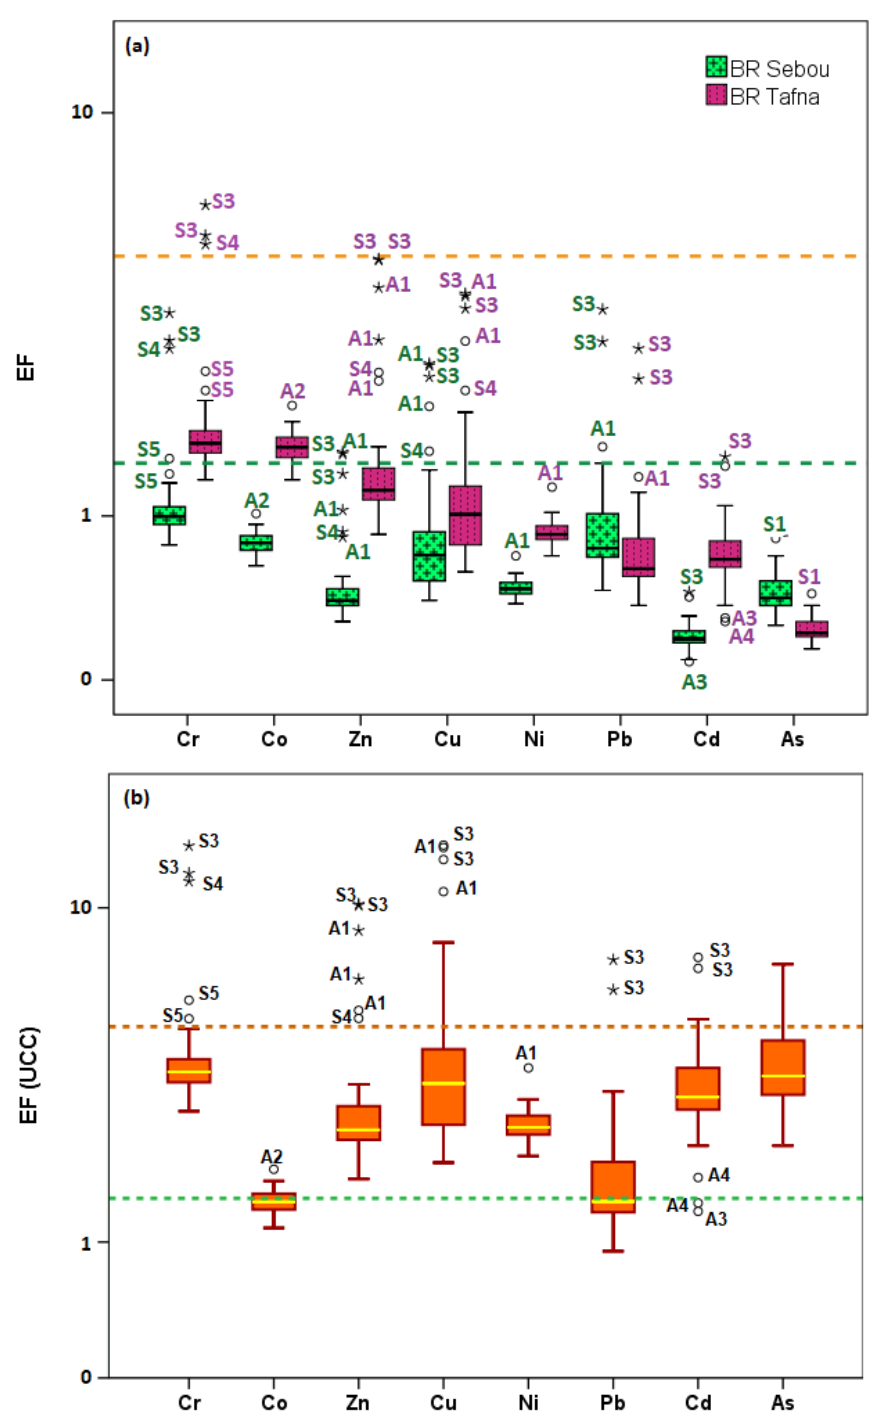
Figure 4. Comparison between the enrichment factor (EF) of trace metals in the river sediments from the Sebou basin normalized to the composition of: ( a ) the bedrocks (BR) of the Sebou (green) and the Tafna (pink) basins and ( b ) the UCC (Upper Continental Crust). The circles and stars represent out and extra outliers, respectively. The green and orange dashed lines indicate the 1.5 and 5 thresholds respectively.